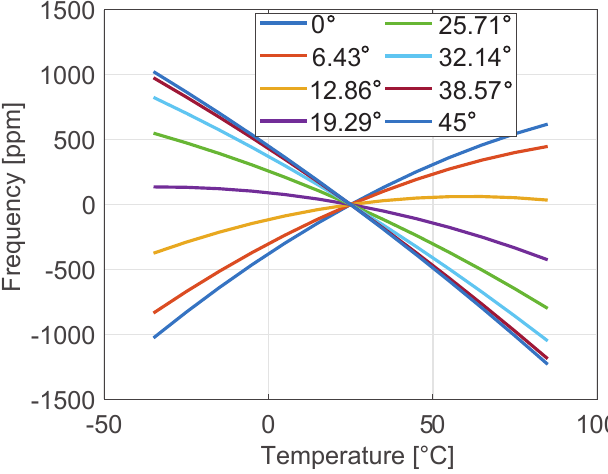
Figure 3. Frequency variation f 0 ( T ) − f 0 ( 25 ◦ C ) relative to f 0 ( 25 ◦ C ) for the tuning fork shown in Figure 2 for different orientations ϑ